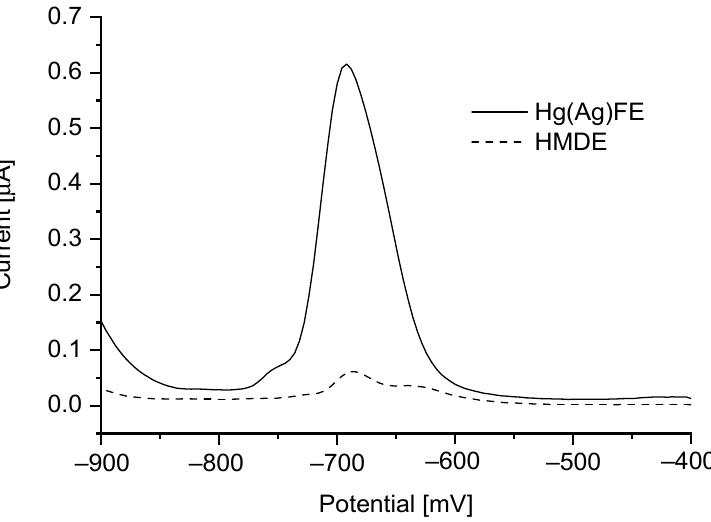
Figure 4. Rifampicin peaks obtained on two types of electrodes: HMDE (1.6 mm 2 ) and Hg(Ag)FE (5.7 mm 2 ) in 0.1 M CH 3 COOH with the same instrumental parameters applied.